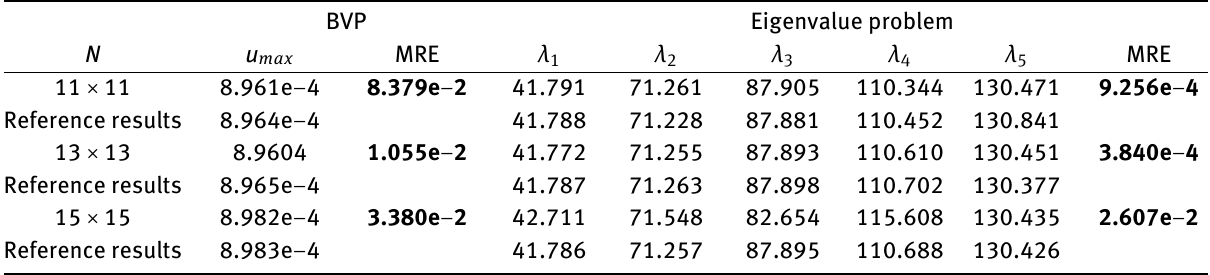
Table 6: The results from solving the biharmonic problems on the triangular domain with corner cut-out. The boundary conditions given by Eq. (28) implemented using strategy 2.